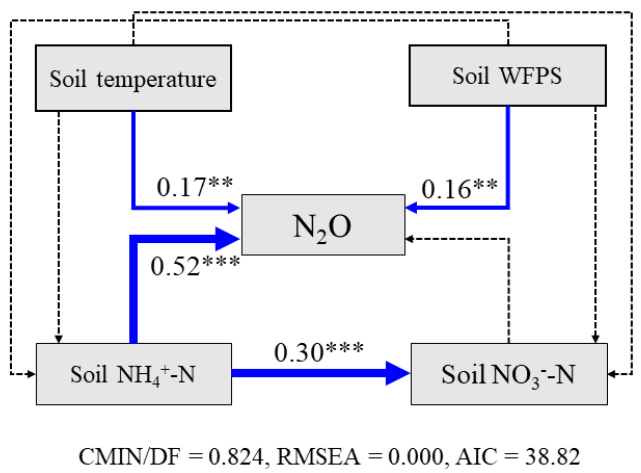
Figure 4. Structure equation model of daily N 2 O emissions and soil environment parameters (soil temperature, soil WFPS, soil NO 3‒ -N, and NH 4+ -N). The solid blue lines indicate a significant effect, whilst the dashed lines indicate no significant effect. Larger path coefficients are reflected in the width of blue lines. The numbers are standardized path coefficients. CMIN/DF, RMSEA, and AIC are goodness of fit statistics. ** p < 0.001, *** p < 0.001. ( n = 208).